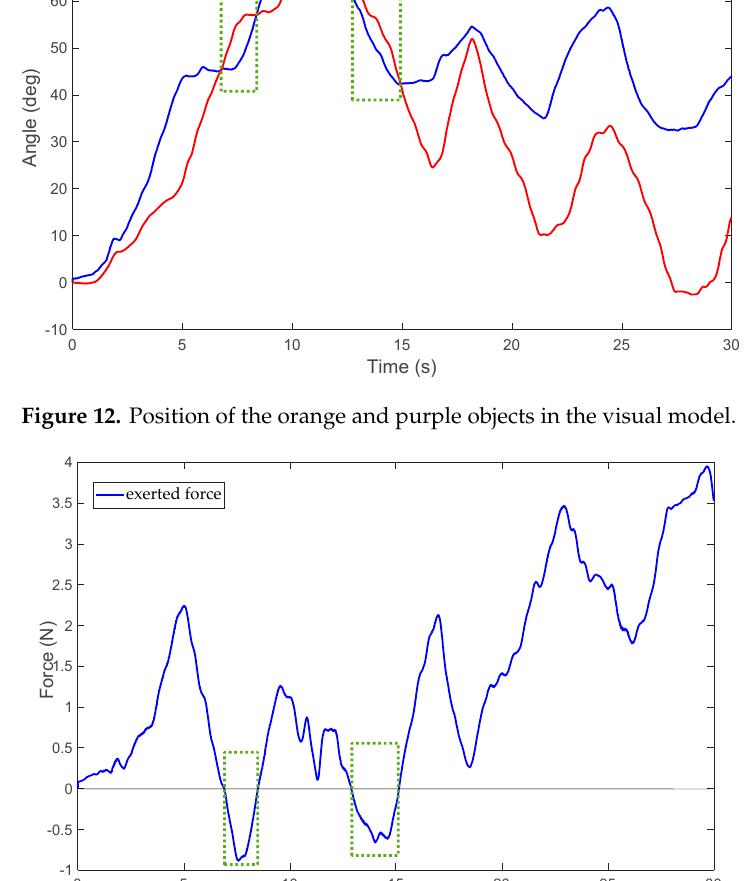
Figure 13. Exerted assistive and resistive force by the therapist by means of the